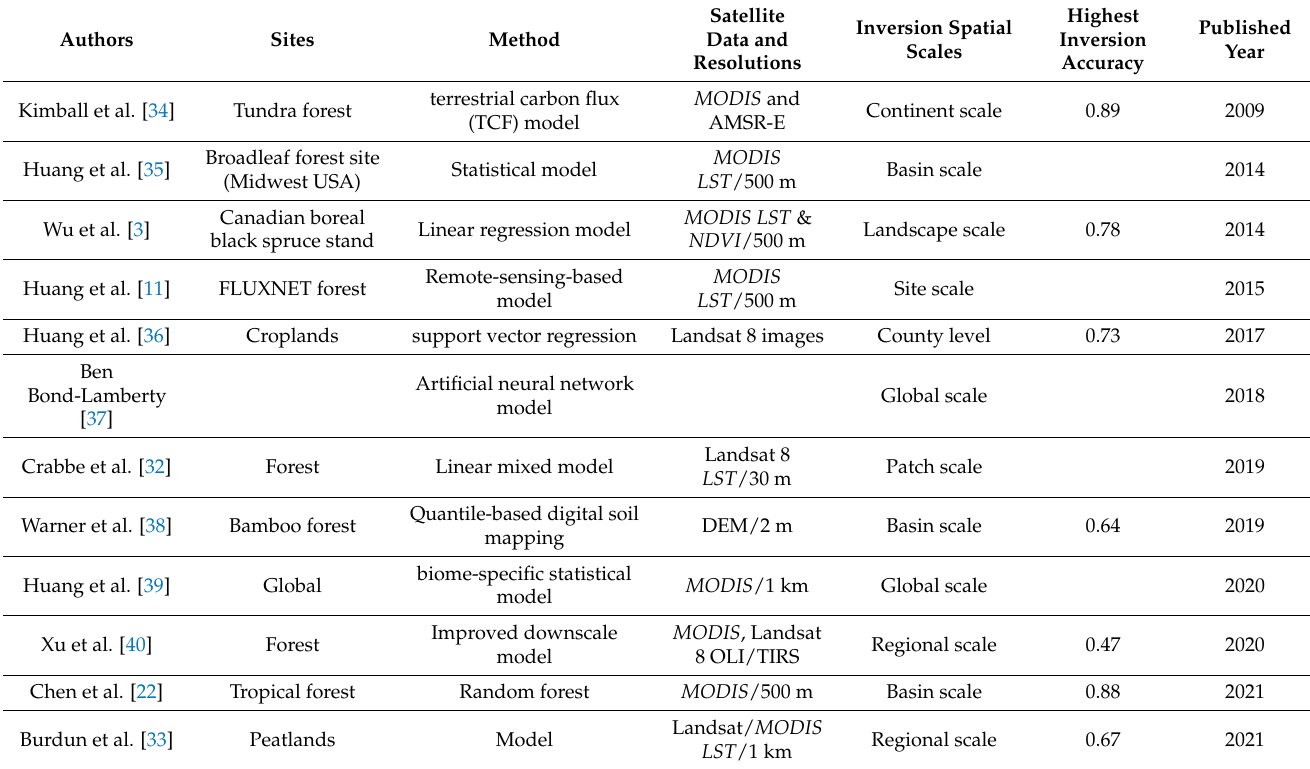
Table 3. Previous studies of remote-sensing-based soil CO 2 efflux monitoring during